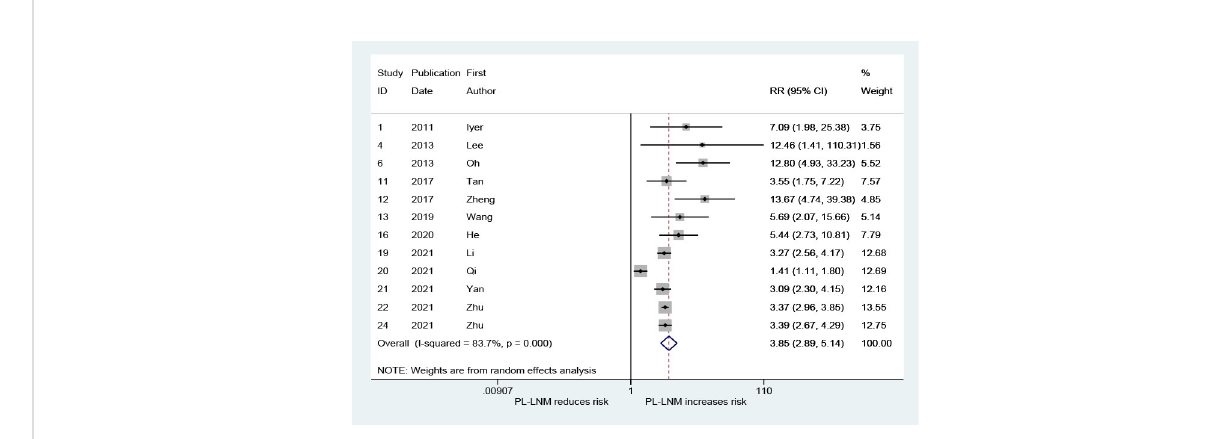
FIGURE 5 The relative risk for lateral lymph node metastasis in patients with prelaryngeal lymph node metastasis